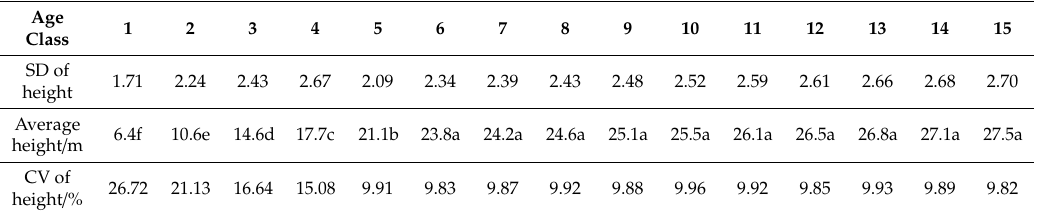
Table 2. Coe ffi cient of variation of dominant height in di ff erent age